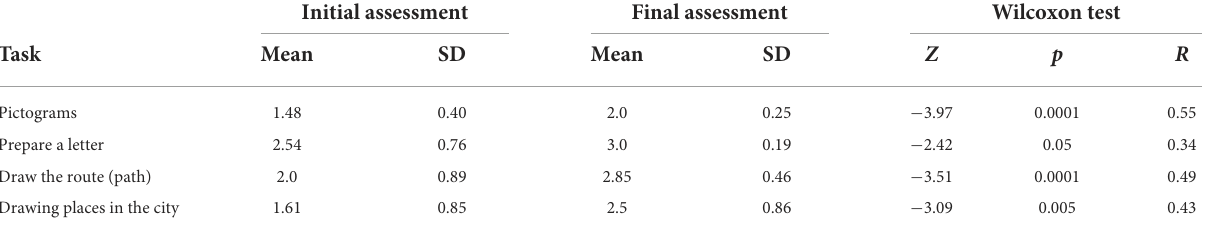
TABLE 3 Statistical results for quantitative